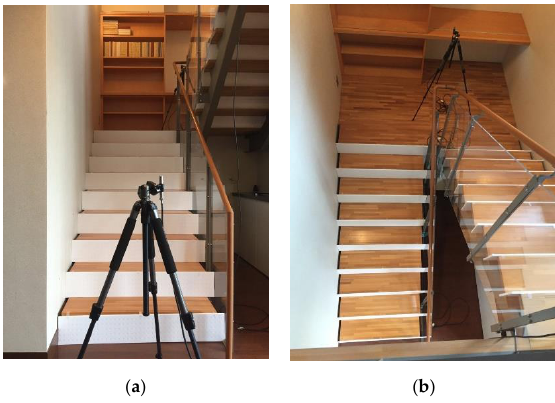
Figure 5. Sound absorption panel installation status in the riser. ( a ) Setup as seen from the first floor. ( b ) Setup as seen from the second floor.